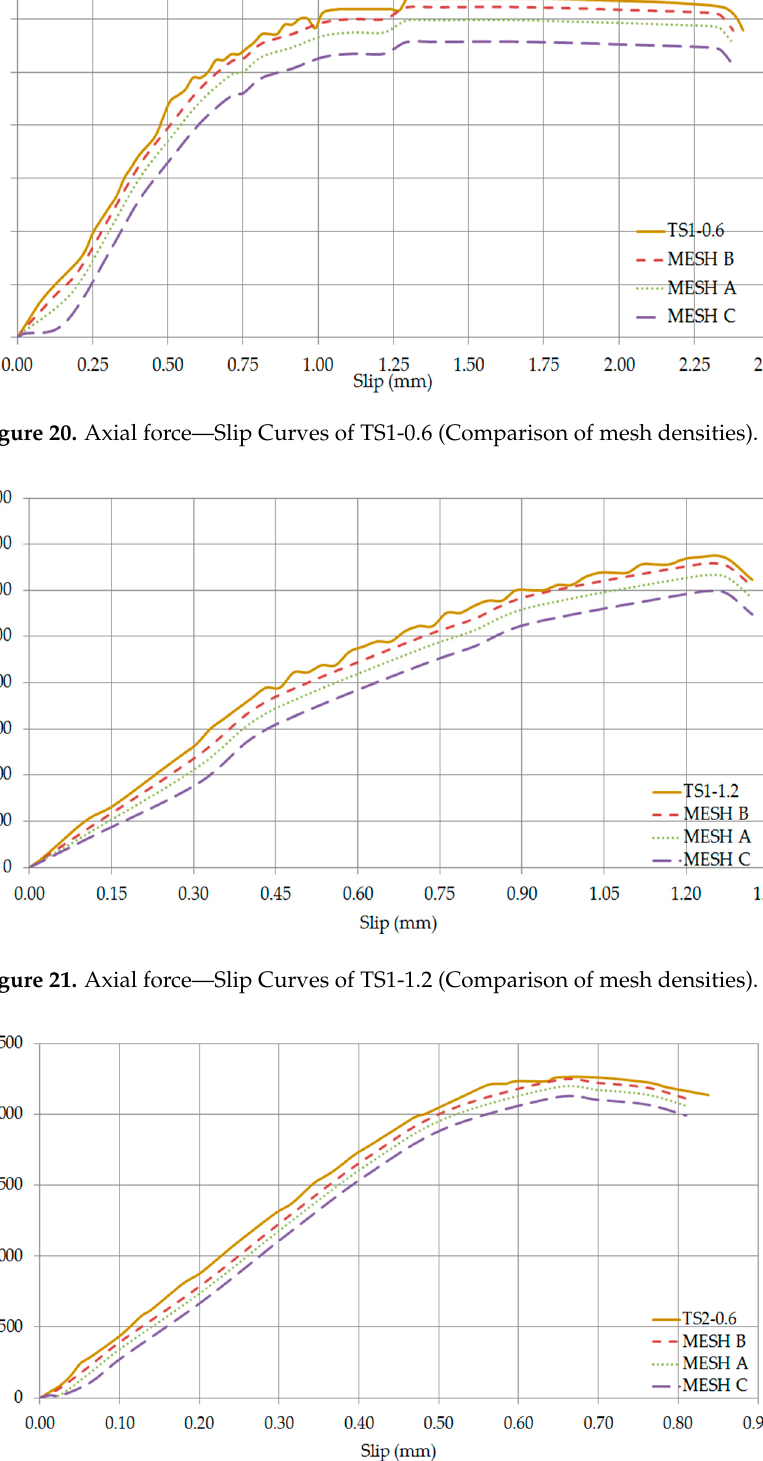
Figure 22. Axial force—Slip Curves of TS2-0.6 (Comparison of mesh densities).